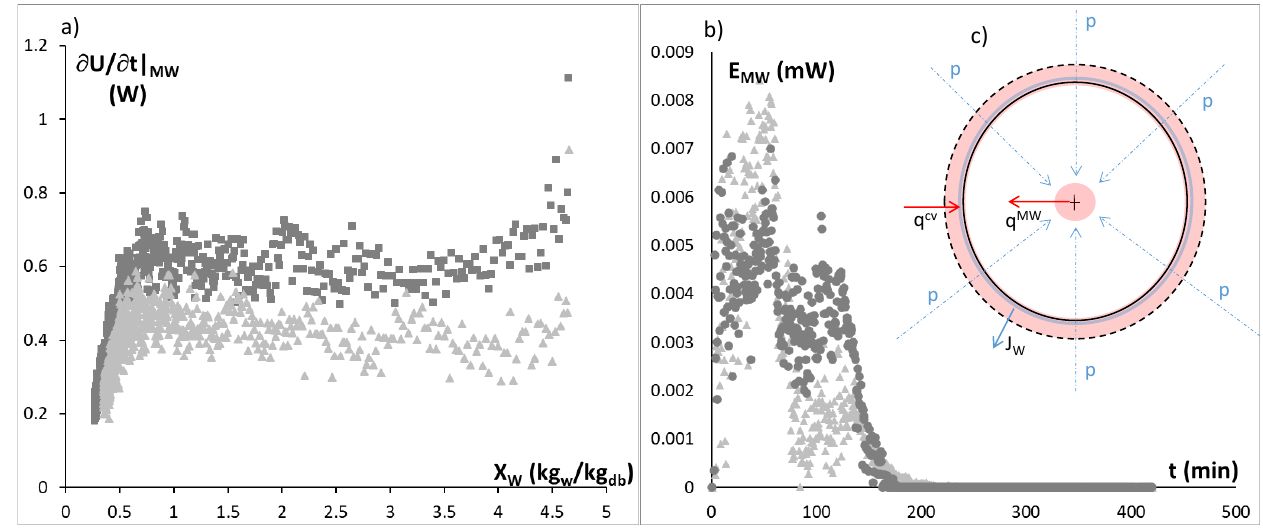
Figure 8. ( a ) Internal energy accumulation throughout the drying time for HAD + 4 W/g ( ▲ ) and HAD + 6 W/g ( ■ ) treatments, ( b ) microwave heating of the boundary layer throughout the drying time for HAD + 4 W/g ( ▲ ) and HAD + 6 W/g ( ■ ) treatments. ( c ) Scheme of the effect of microwaves in sample heating, where p represents the photon fluxes, q MW represents the heat conduction produced by the microwave heating source in the sample center, Jw is the water flux and q cv is the heat convection.